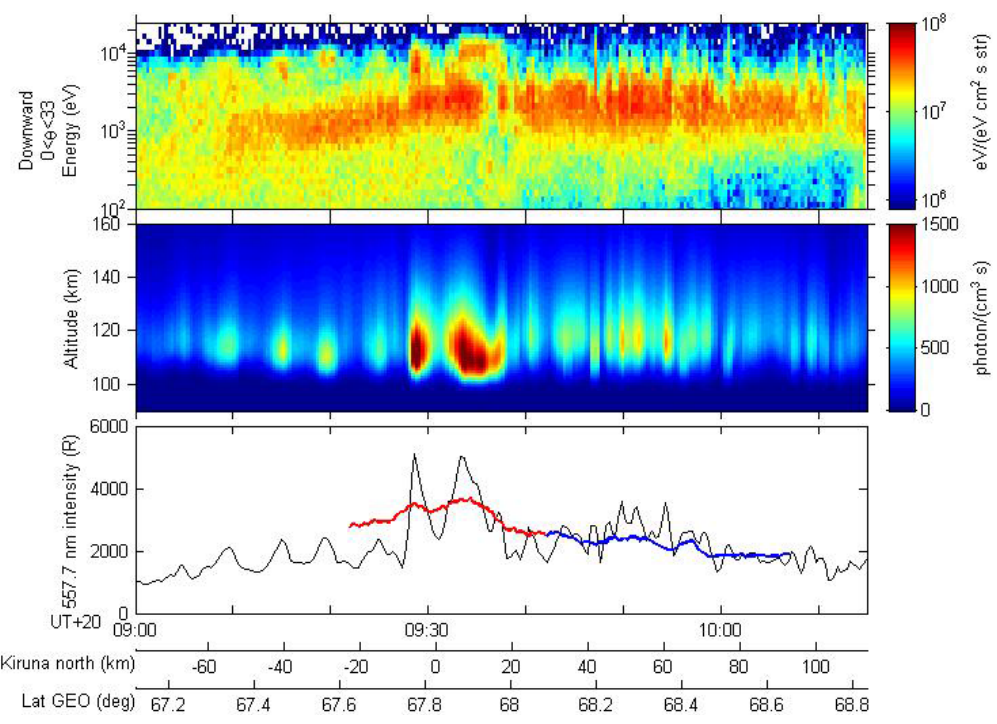
Fig. 7. Upper panel: Downward electron differential flux as a function of time and energy mapped down to 500km. Middle panel: Calculated altitude profiles of the volume emission rate of the 557.7nm emission. Bottom panel: Column intensities of the 557.7nm emission. The black line gives the calculated results. The red line shows intensities taken from the Abisko image at 20:09:30UT. The blue line shows intensities taken from Abisko image at